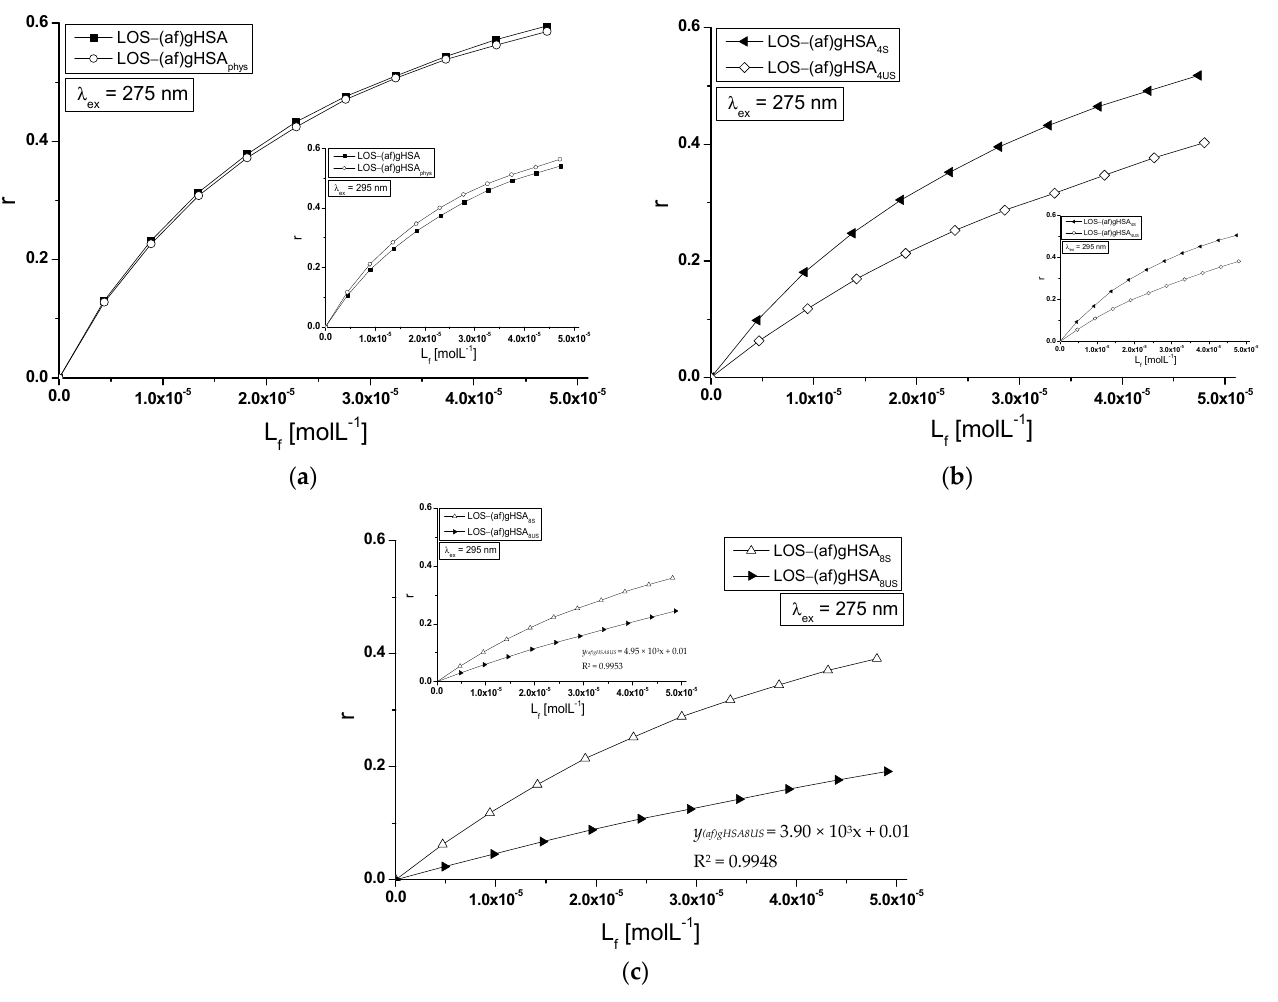
Figure 6. Binding isotherms of ( a ) (af)gHSA, (af)gHSA phys , ( b ) (af)gHSA 4S , (af)gHSA 4US , and ( c ) (af)gHSA 8S , (af)gHSA 8US at 5 × 10 − 6 mol ∙ L − 1 concentration with LOS at 5 × 10 − 6 –5 × 10 − 5 mol ∙ L − 1 concentration, λ ex = 275 nm (in the main view), λ ex = 295 nm (in the insert); the error bars are smaller than the symbols.